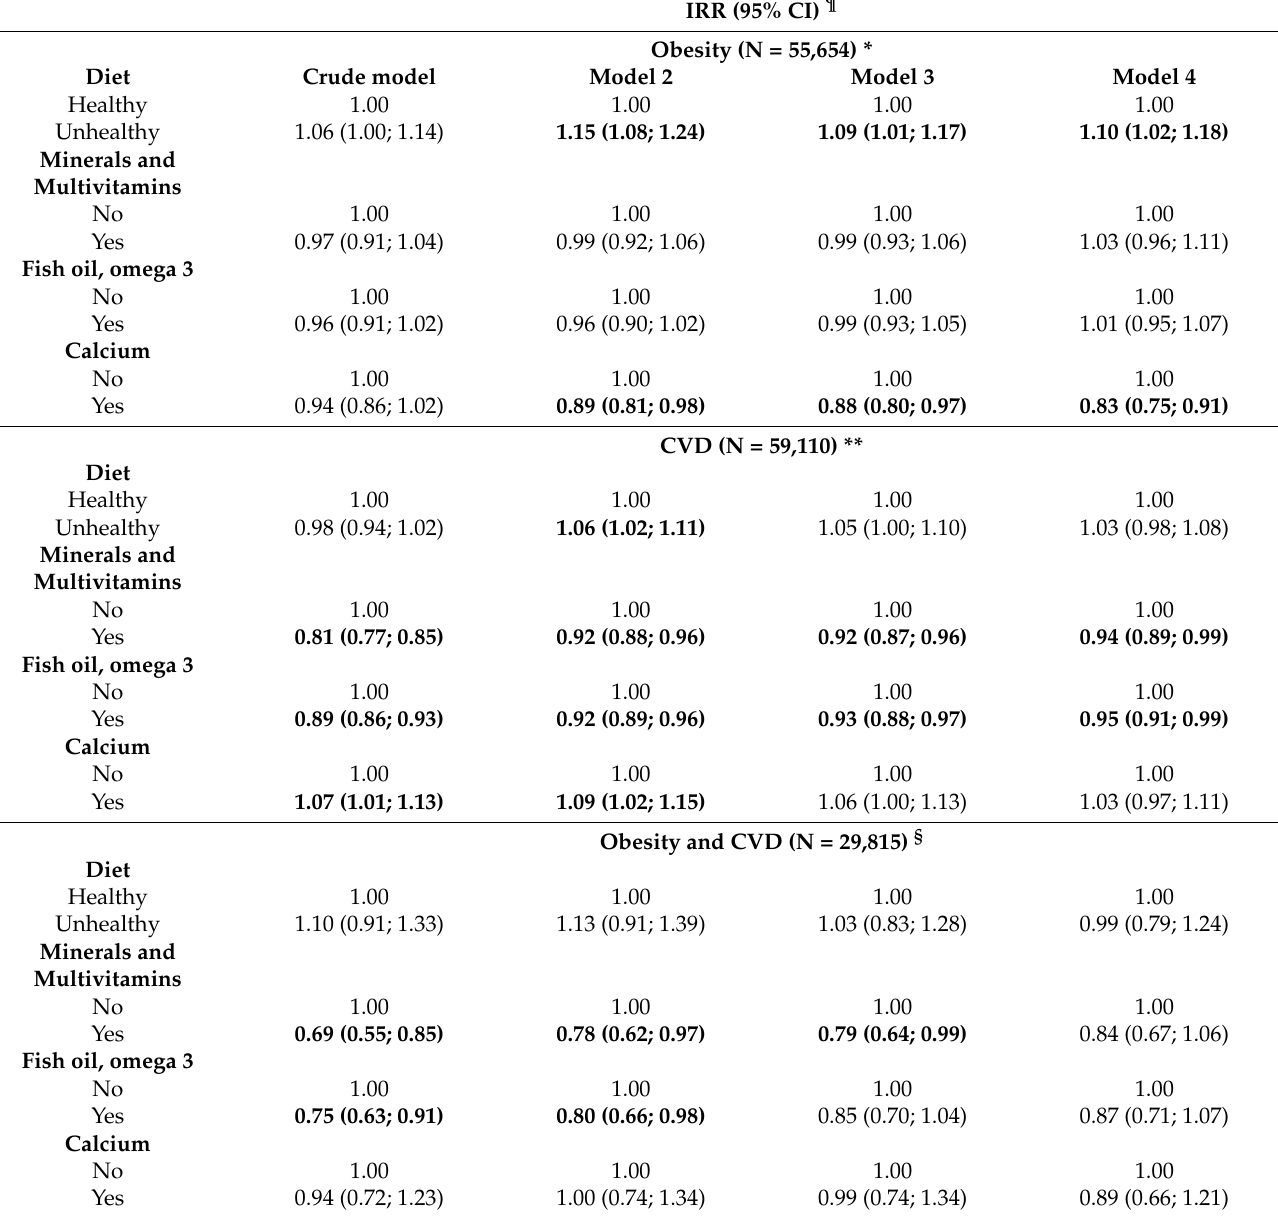
Table 2. The association between dietary or individual supplement consumption and the incidence of obesity, CVD, or